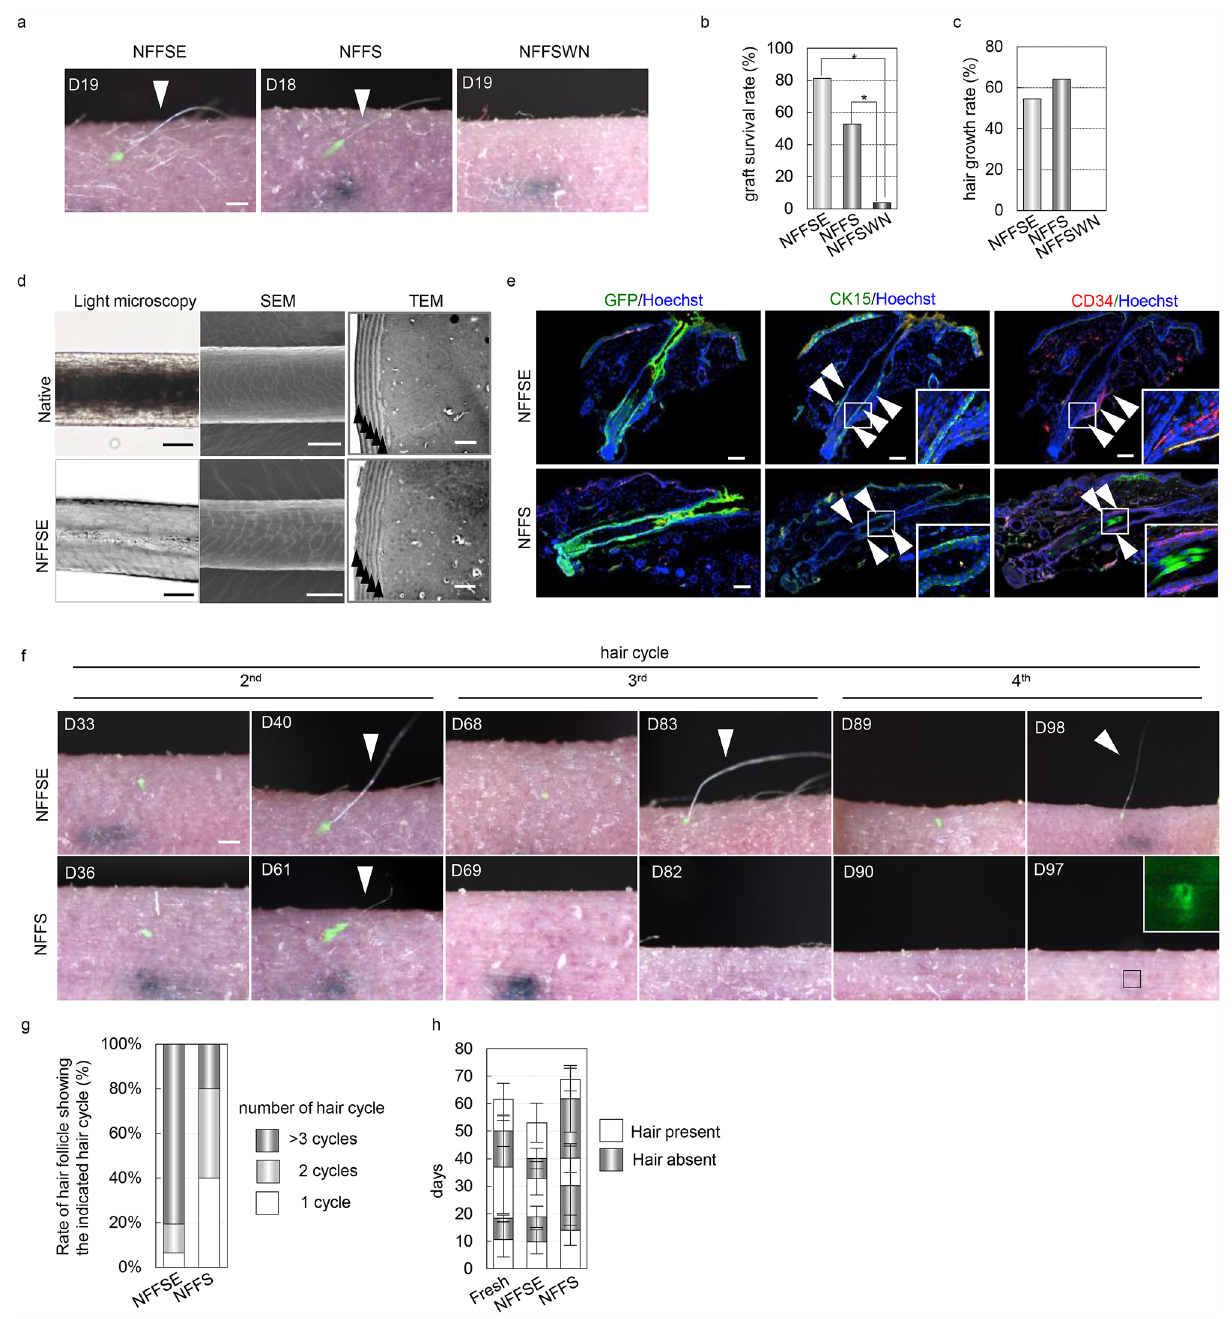
Figure 3. NFFSE cultured cells have the ability to undergo repetitive HF regeneration. ( a ) Macro- morphological observations of transplanted bioengineered HF germ generated from vibrissa bulge cells cultured in the indicated medium. Bioengineered HF germ generated from cultured HF epithelial cells and dermal papilla cells, which were isolated from adult vibrissa HFs, was transplanted into back skin of nude mice intracutaneously. ( b ) Quantification of graft survival rate, ( c ) Quantification of first hair growth rate after transplantation. ( d ) Microscopic observation of the regenerated hair shafts by light microscopy, scanning electron microscopy (SEM), and transmission electron microscopy (TEM). ( e ) Representative immunofluorescence of the indicated markers on regenerated HFs. ( f ) Long-term hair cycle analysis of regenerated HFs. ( g ) Quantification of the percentage of regenerated HFs showing indicated number of the hair cycle ( s ). ( h ) Quantification of the duration of days with or without hair shaft in each hair cycle. Arrowheads indicate the regenerated hair shaft in ( a , f ), cuticle layers in ( d ), and expression of indicated markers in ( e ). Data are presented as the mean ± SD. *p < 0.01. Scale bars, 100 μm in ( a , f ); 20 μm in the left and middle panel and 2 μm in the right panel of ( d ); 20 μm in ( e